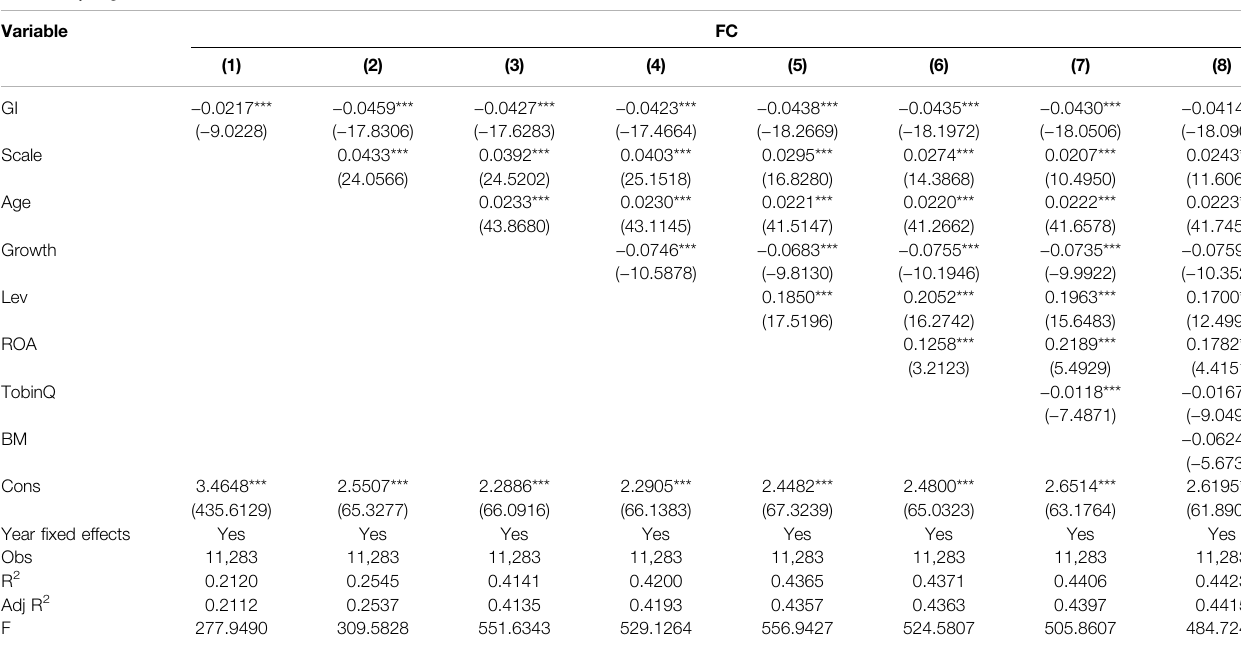
TABLE 6 | Regression results of M 1